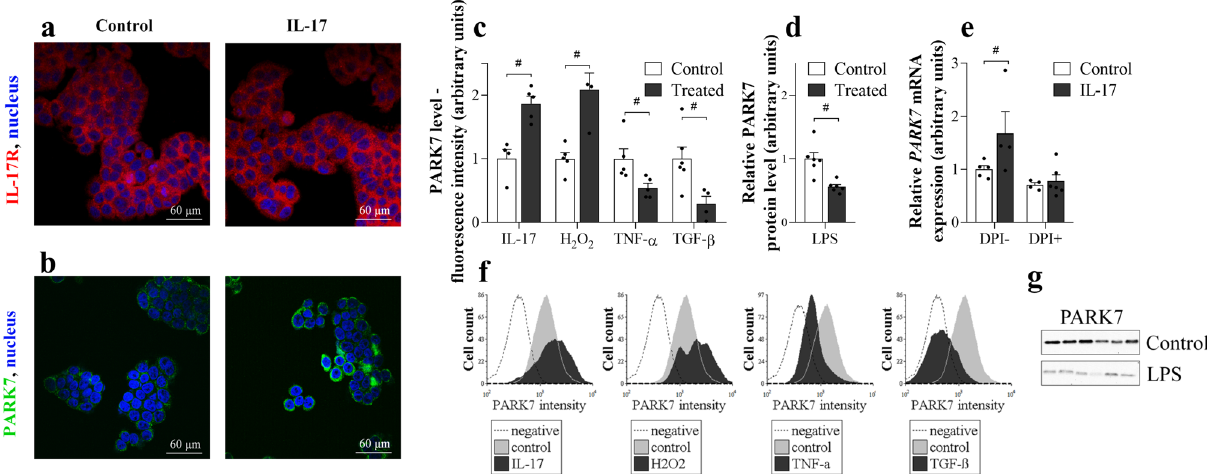
Figure 2. Effect of IL-17, H 2 O 2 , TNF-α, TGF-β, LPS, or DPI treatment on PARK7 synthesis of HT-29. IL-17R ( a , red) and PARK7 ( b , green) were visualized by immunofluorescent staining. Cell nuclei were counterstained with Hoechst 33342 (blue). Scale bar: 60 µm. PARK7 amount after various treatments (n = 4–6) was determined by flow cytometry ( c , f ), western blot ( d , g ) or real-time PCR ( e ). Relative expression levels are presented in comparison with total protein amount ( a ) or GAPDH mRNA ( b ) as internal control and normalized to vehicle treated group. Results are illustrated as mean + SEM, dots represent individual values. Analysis of significance was performed by Mann–Whitney test. # p < 0.05 comparing the connected groups. Full-length blots are included in “Supplementary